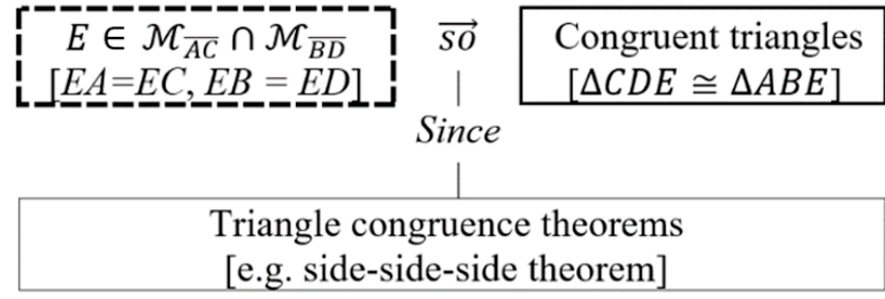
Figure 8. Abductive argument to solve the problem.